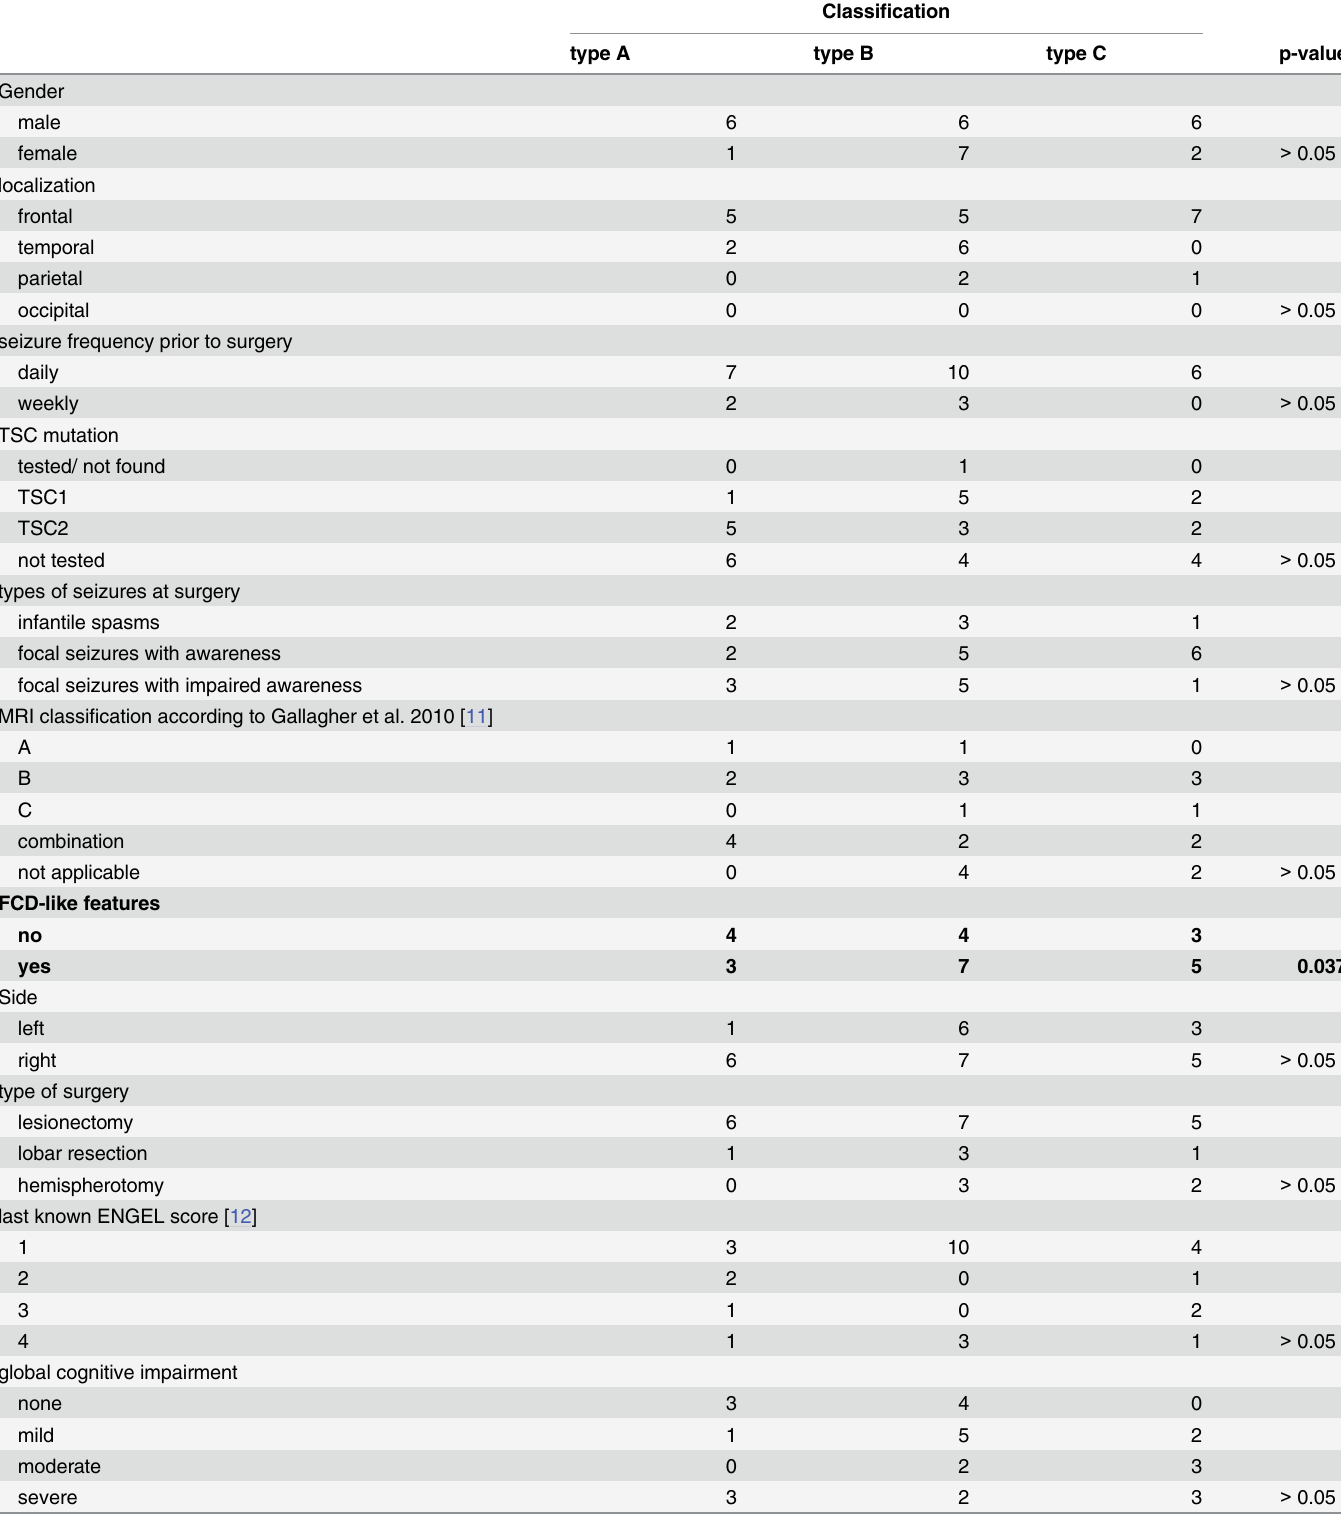
Table 2. Patients